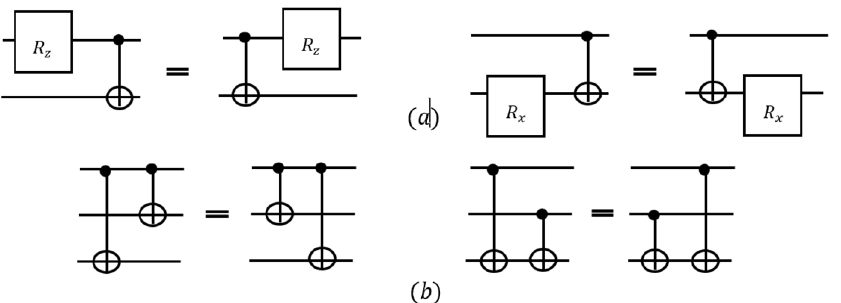
Figure 5. ( a ) Commuting of the rotation gates and the CNOT gate. ( b ) Commuting of two CNOT gates in two different circumstances 38 .